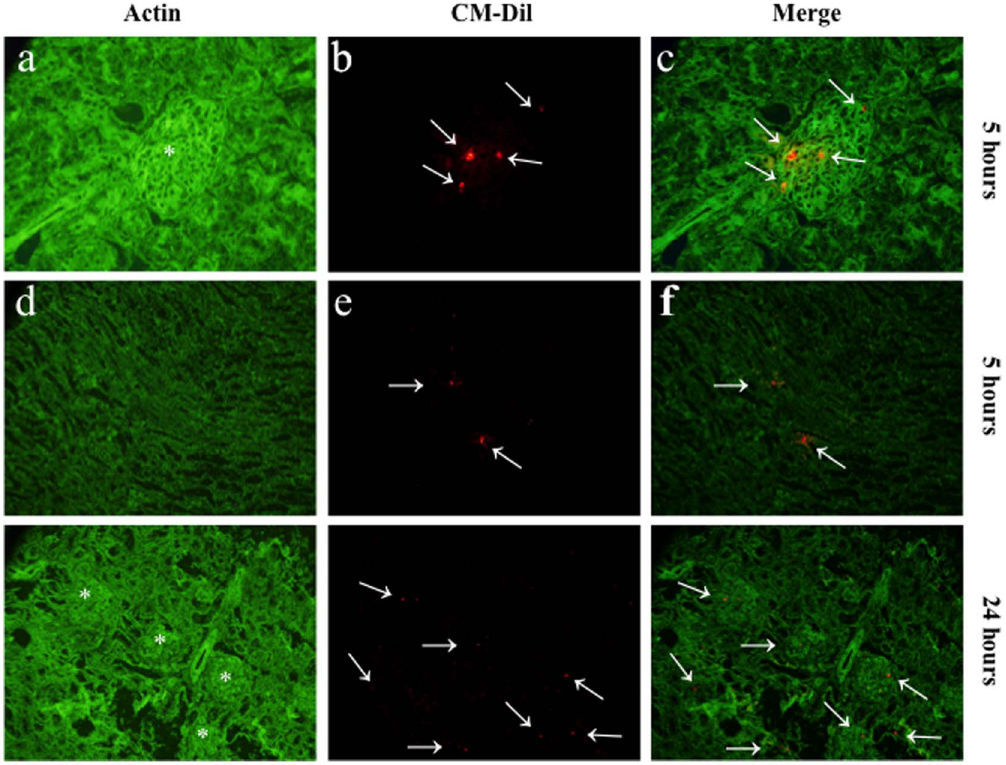
Figure 7. Detection of CM-DiI-labeled MSCs in kidneys. Representative pictures of frozen tissue sections of kidney of an MSC-treated rat at 5 h (a–f) or 24 h (g-i) after CM-DiI-labeled hMSC administration. The presence of CM-DiI-labeled hMSCs (red stained cells; arrows) was examined by counterstaining with actin antibody (green staining). Original magnifications, x400 (a–f), x200 (g–i). Asterisk (*) represents glomerulus.